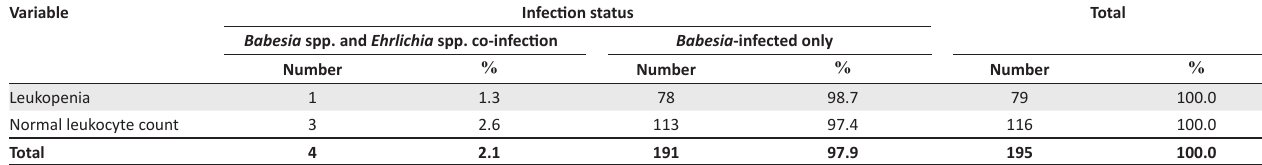
TABLE 2: Contingency table illustrating the relationship between infection status and leukocyte count.